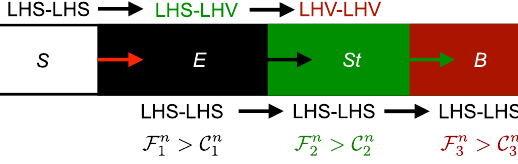
C n F n C n 1 (5), 2 ≤ 2 (3) and ≤